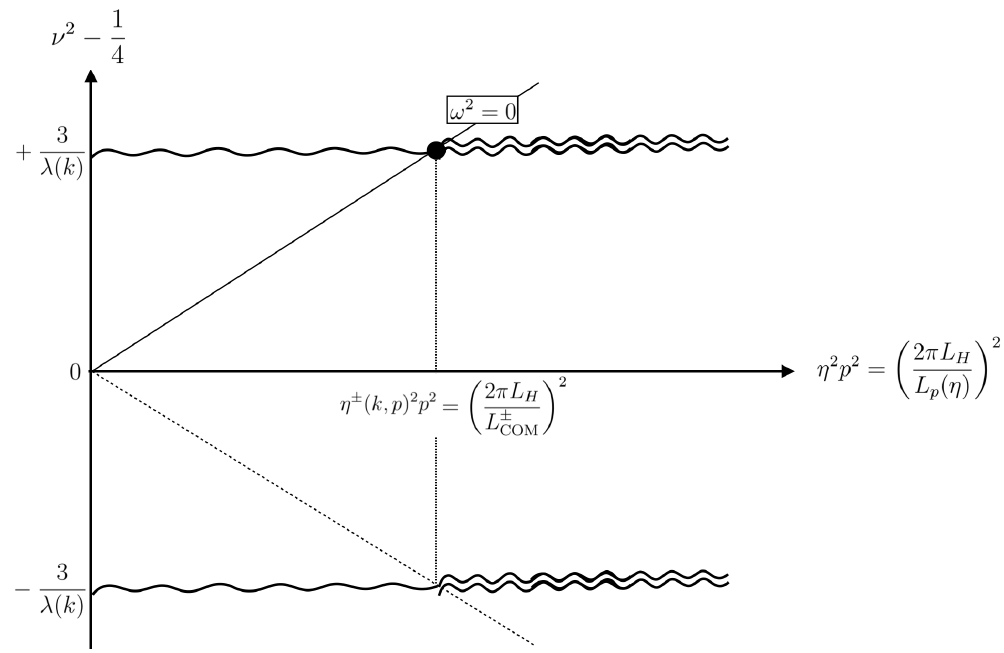
Figure 10. The cutoff modes, and the respective subsets of the COMs which are detected according to Models A and B. The black dot indicates the detected modes of Model A, the wavy double lines those of Model B. The diagram assumes that λ ( k ) (cid:28) 1 , in which case L −